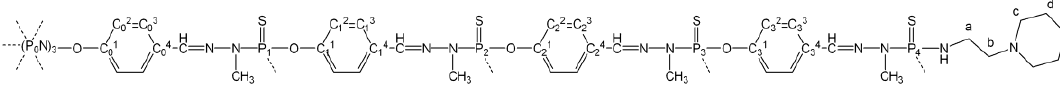
Figure 1. Numbering used for NMR assignments.